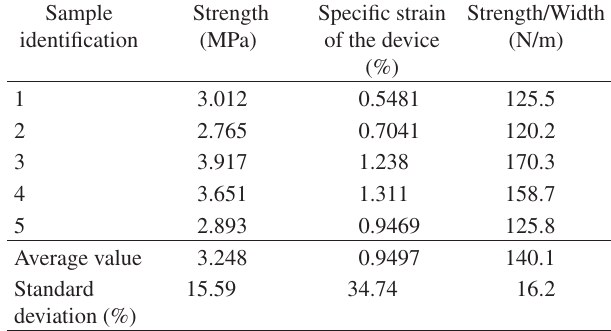
Table 5. Shear test results – resin impregnated Eucalyptus citriodora